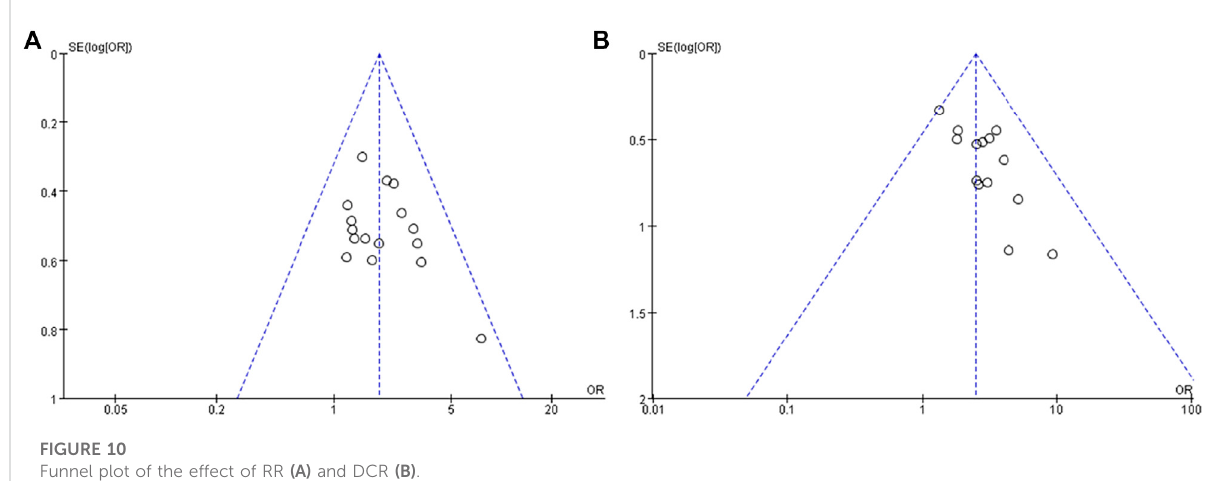
FIGURE 10 Funnel plot of the effect of RR (A) and DCR (B)